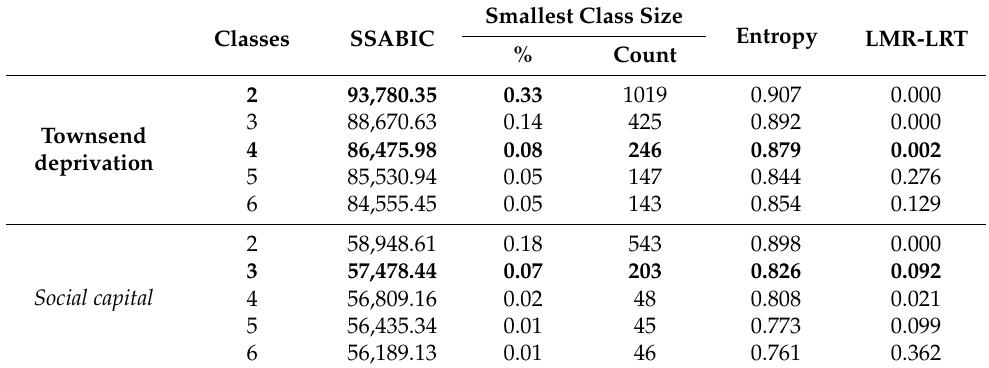
Table 3. LCGA model comparison with different numbers of classes (selected model highlighted in